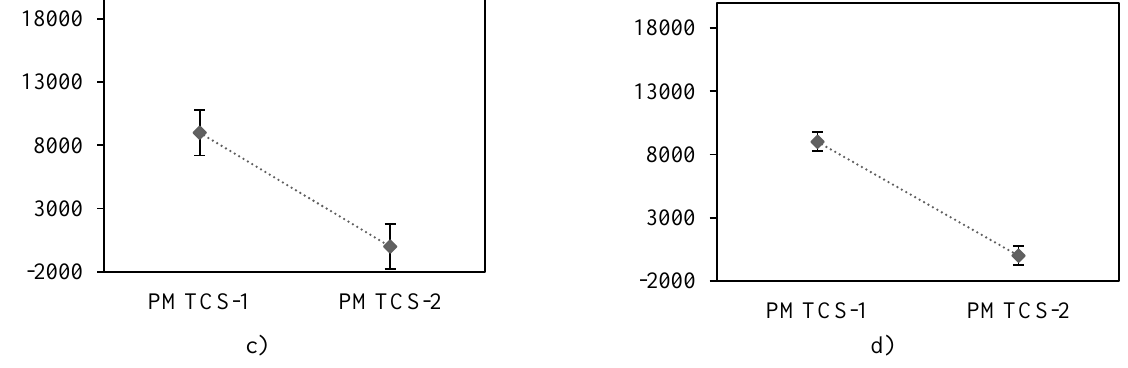
Fig. 4. Means plot with 95% LSD intervals for problems with a) 6 jobs; b) 8 jobs; c) 12 jobs; d) 15